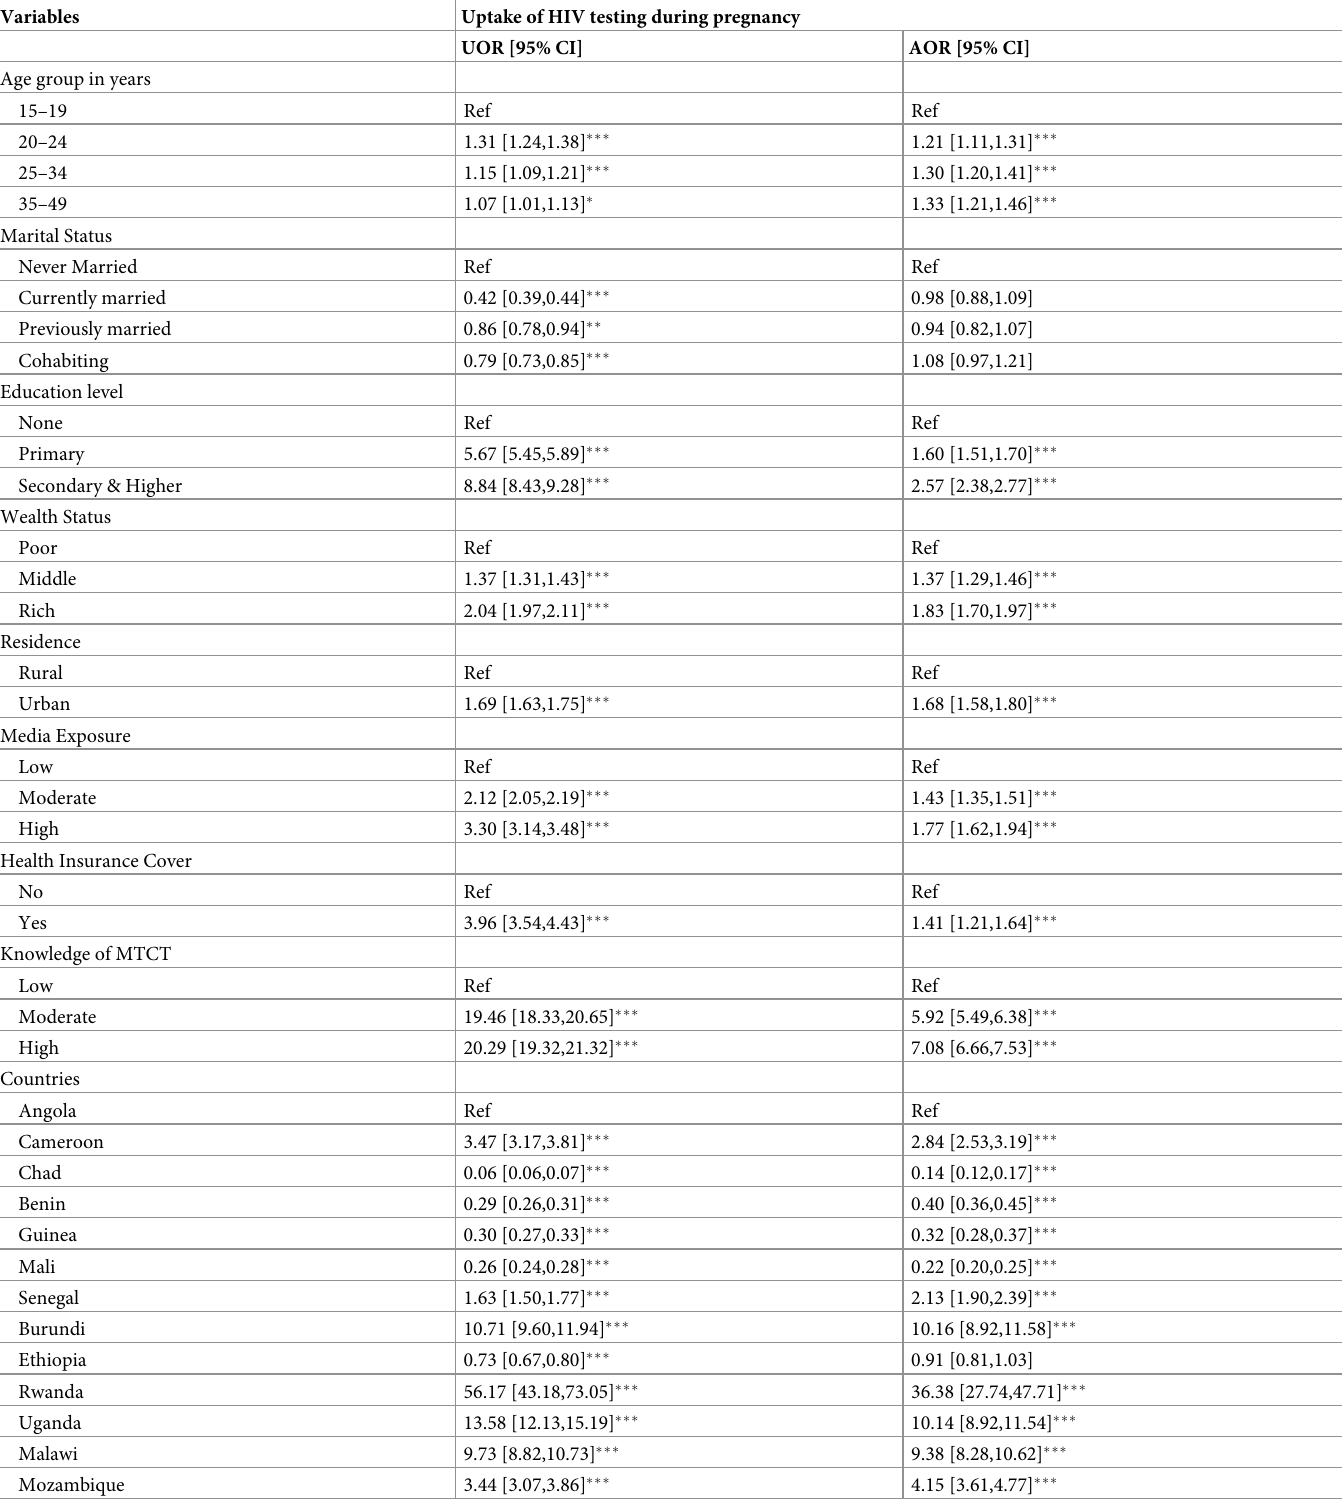
Table 3. Multivariable models showing factors associated with uptake of HIV testing in